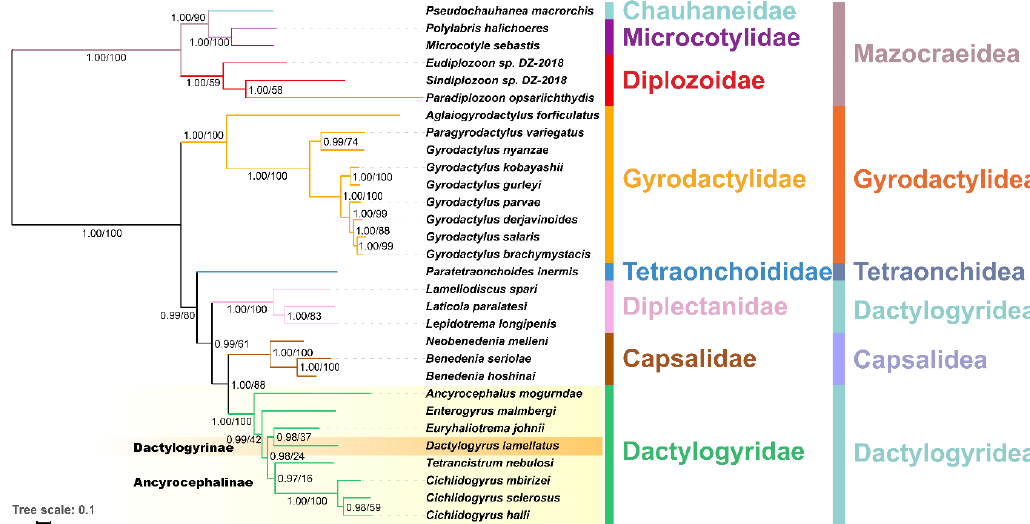
Figure 3. A phylogram reconstructed using mitogenomes of 30 monogeneans (amino acid sequences of all PCGs) and the mtZOA model. Scale bar corresponds to the estimated number of substitutions per site. Statistical support values of Bayesian analyses and maximum likelihood are shown on the nodes (left/right, respectively). Taxonomic families and orders are shown in different colors. Dactylogyrinae and Ancyrocephalinae subfamilies are also